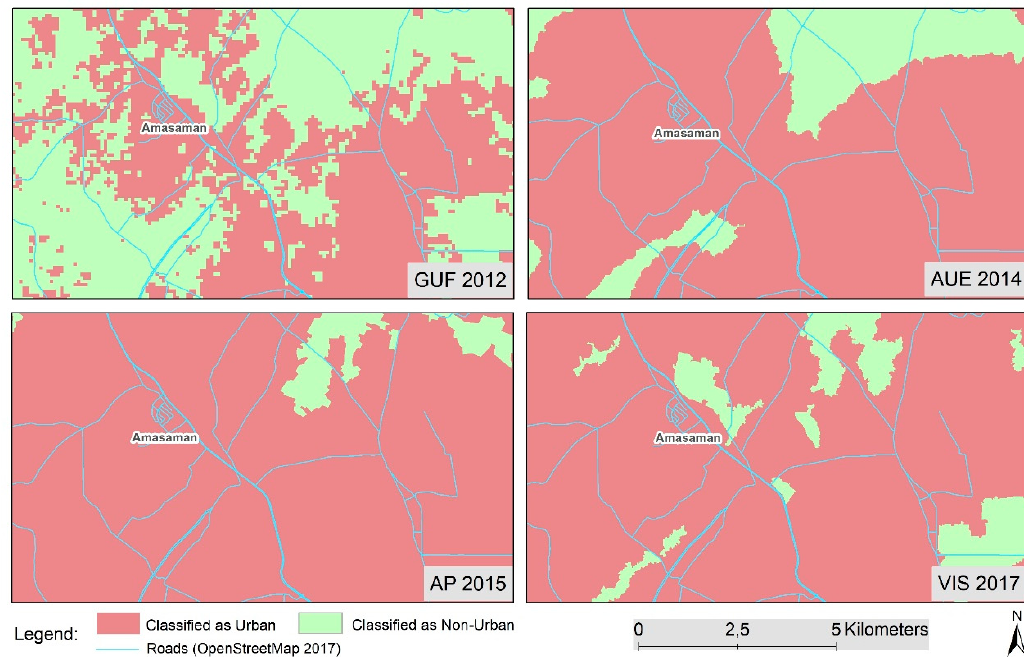
Figure 5. Estimates of the spatial extent of the Accra agglomeration for the period (1985–1991). Contributing datasets: Atlas of Urban Expansion (AUE) and Landsat-TM texture (TM). Road network from OpenStreetMap 2016 (https:/www.openstreetmap.org).